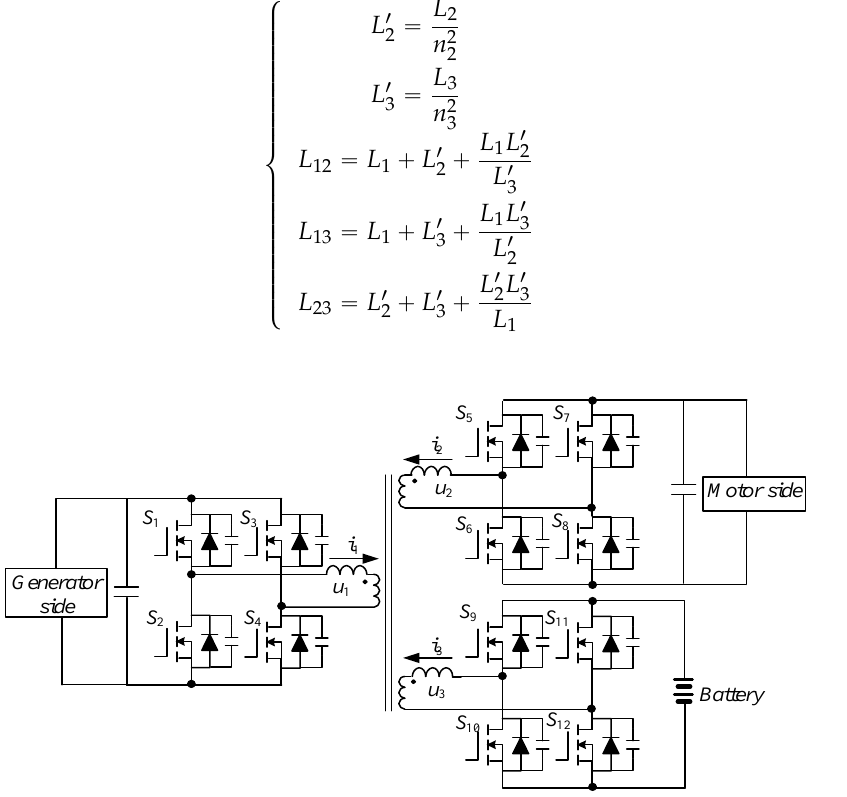
Figure 4. Configuration of TPI bidirectional DC-DC converter.